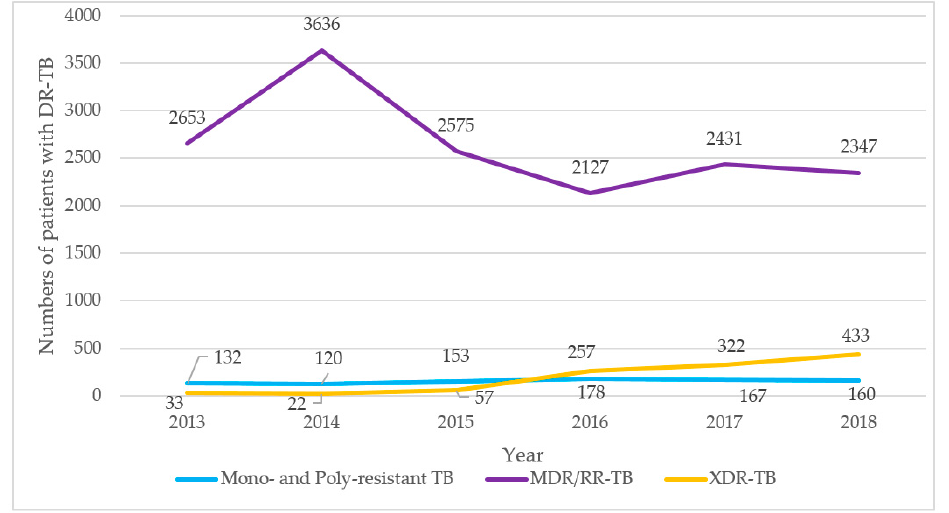
Figure 1. Trends in numbers of patients with different types of drug-resistant tuberculosis enrolled for treatment in Uzbekistan between 2013 and 2018. TB = tuberculosis; DR-TB = drug resistant TB; MDR-TB = multidrug-resistant TB; RR-TB = rifampicin-resistant TB; XDR-TB = extensively drug resistant TB.